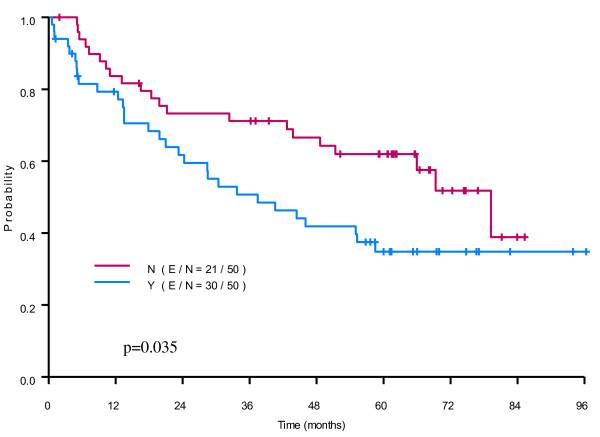
The Kaplan-Meier curve and p-value from stratified Cox proportional hazards model for OS are shown in the figure. Our analysis showed a statistically significant association between blood transfusion and overall survival.